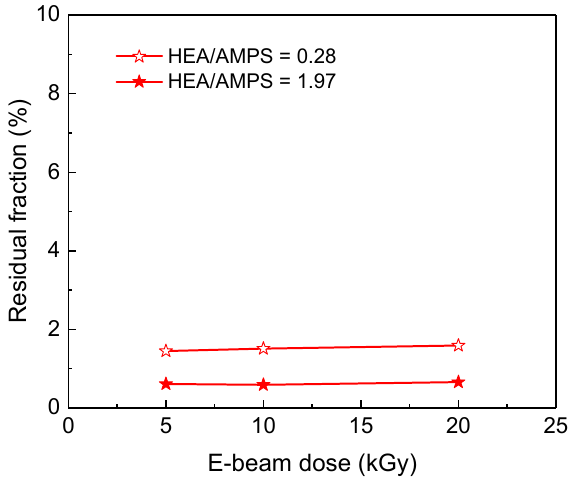
Figure 7. Residual fraction of model HEA-co-AMPS hydrogels as a function of the E-beam dose.